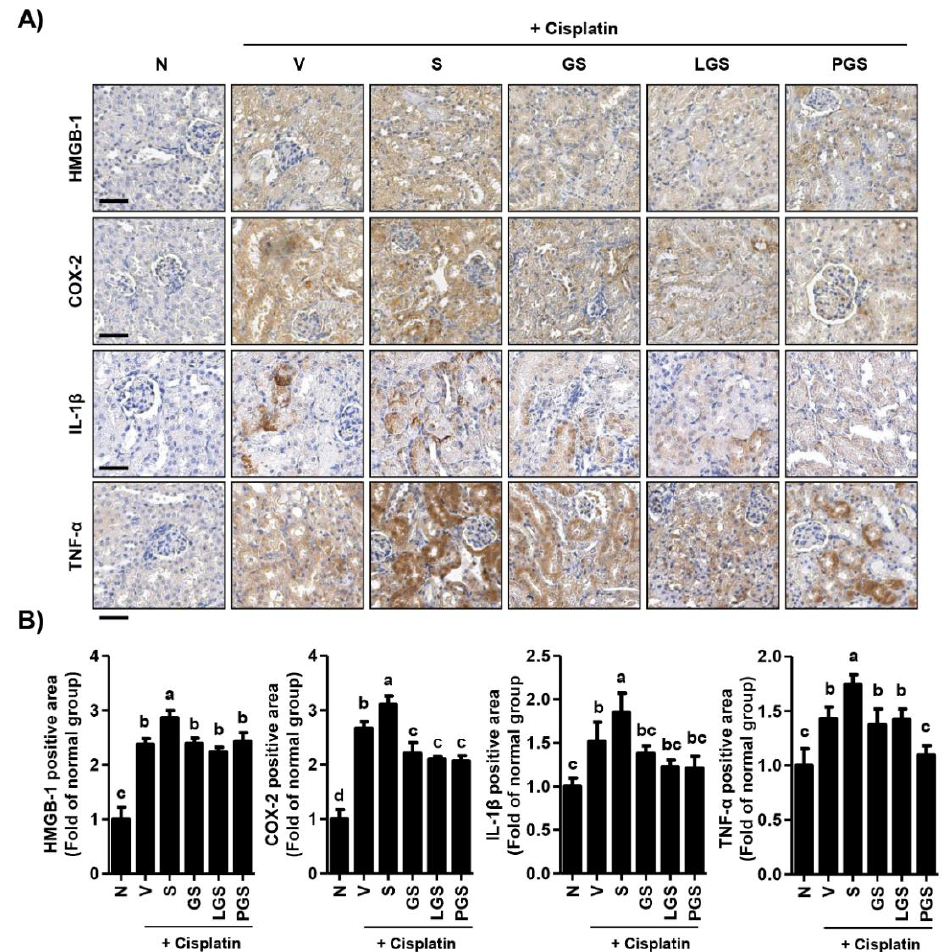
Figure 4. Effect of GABA salt on renal inflammation in cisplatin-induced acute nephrotoxicity. ( A ) Intra-renal expression levels of high mobility group box-1 (HMGB-1), cyclooxygenase-2 (COX-2), interleukin-1 β (IL-1 β ), and tumor necrosis factor- α (TNF- α ). Scale bar = 100 µ m. ( B ) Quantitative analysis for the positive area of HMGB-1, COX-2, IL- 1β and TNF - α. Data are expressed as means ± SD ( n = 4). a – d Bars with different letters are significantly different at p < 0.05 by Tukey test. N, normal group; V, cisplatin + saline group; S, cisplatin+ 4% high salt group; GS, cisplatin + high salt containing GABA group; LGS, cisplatin + 4% sodium containing lacto GABA salt group; PGS, cisplatin + 4% sodium containing postbiotics GABA salt group.